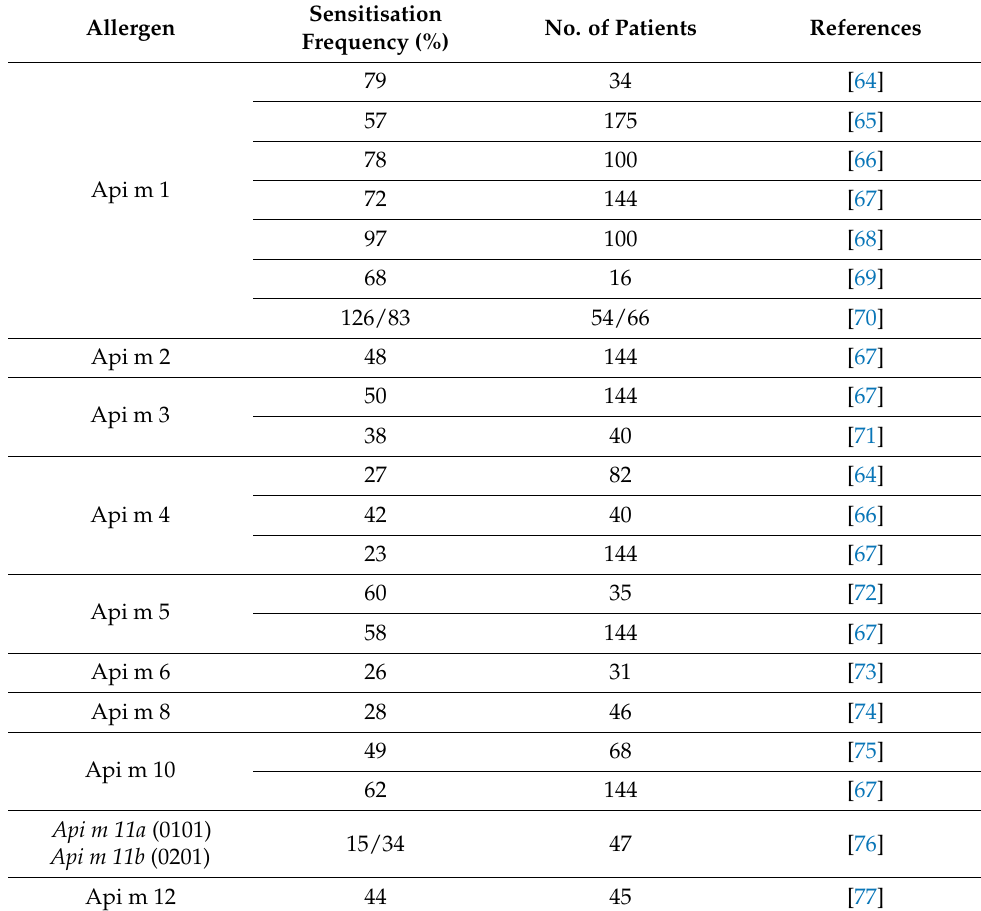
Table 4. Rates of sensitisation to honeybee venom recombinant allergens in Hymenoptera venom allergic